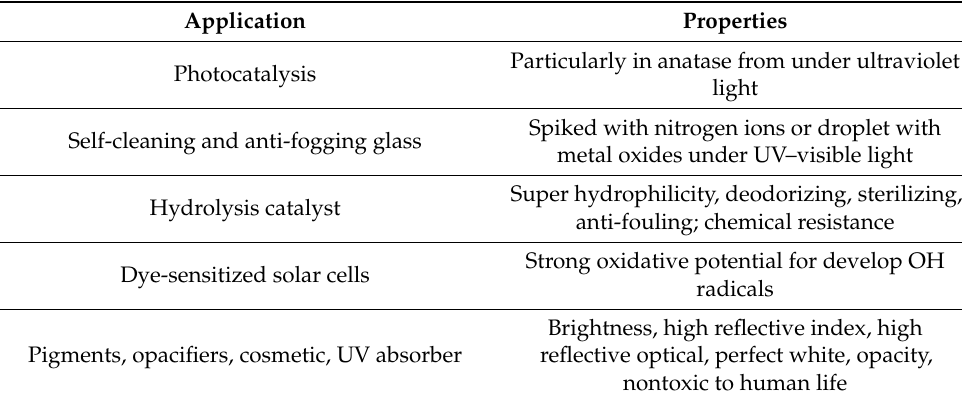
Table 2. Some properties of TiO 2 and